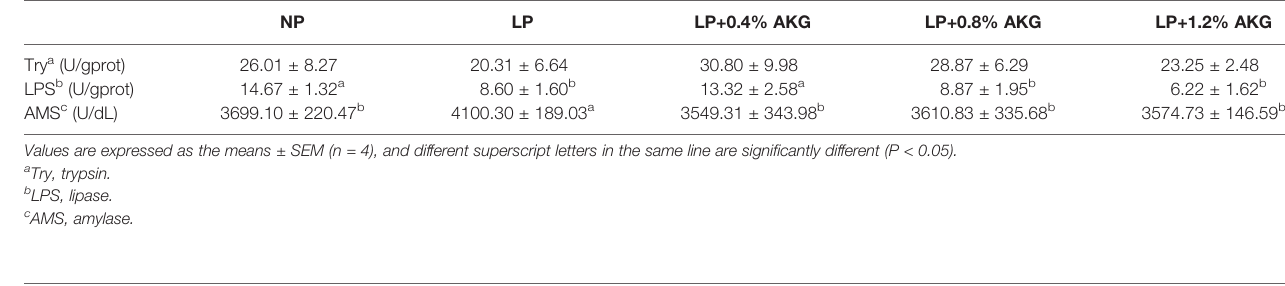
TABLE 3 | Digestive enzymes s of common carp ( Cyprinus carpio ) fed with diets containing normal protein (NP), low protein (LP), and different concentrations of alpha- ketoglutarate (AKG) after 8 weeks. NP